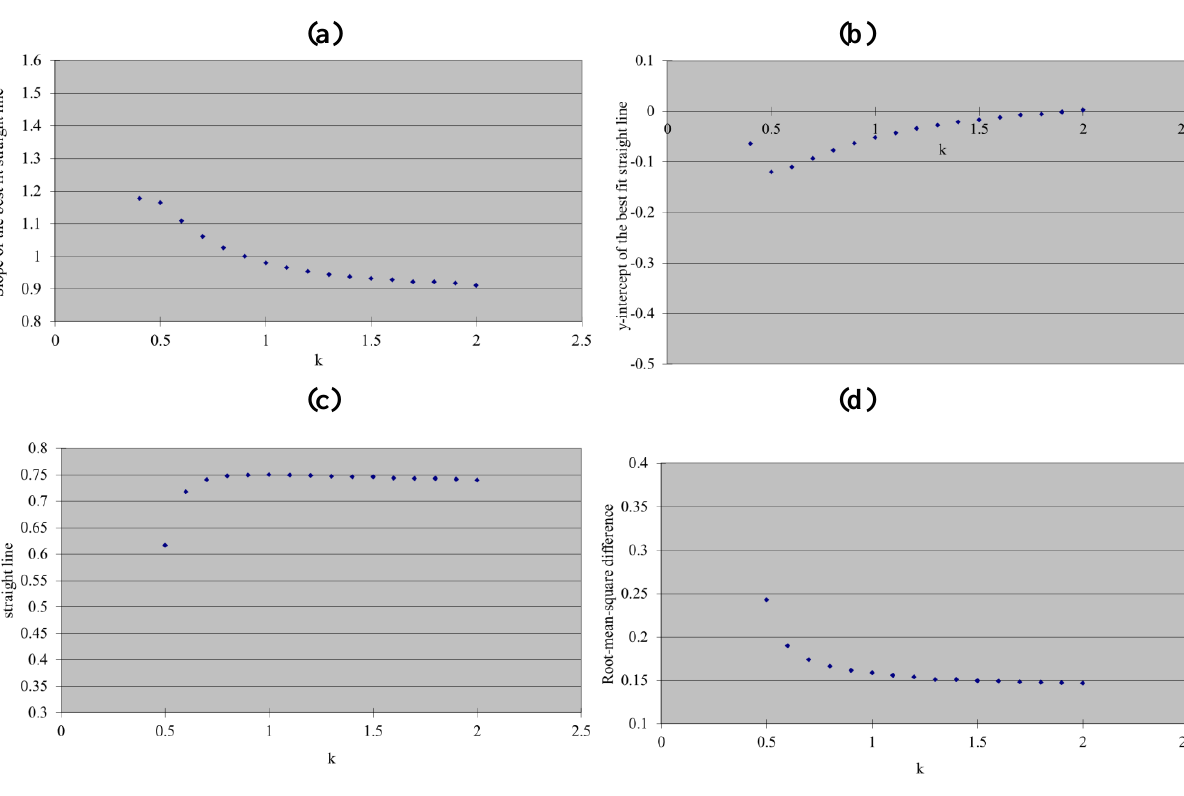
Figure 5. Scatter plot of the LIDAR-derived AOD and sunphotometer-measured AOD in the period July 2009 to May